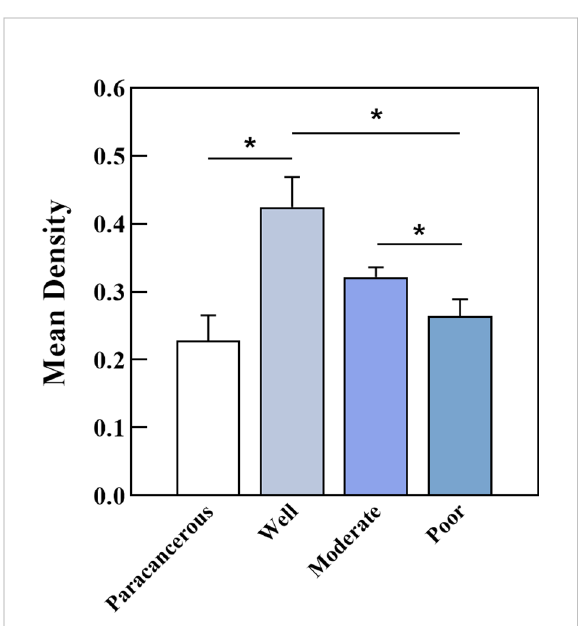
FIGURE 3 Average optical density of PCNP in well, moderately, and poorly differentiated OSCC. Well-differentiated OSCC had high expression in IHC (*P <